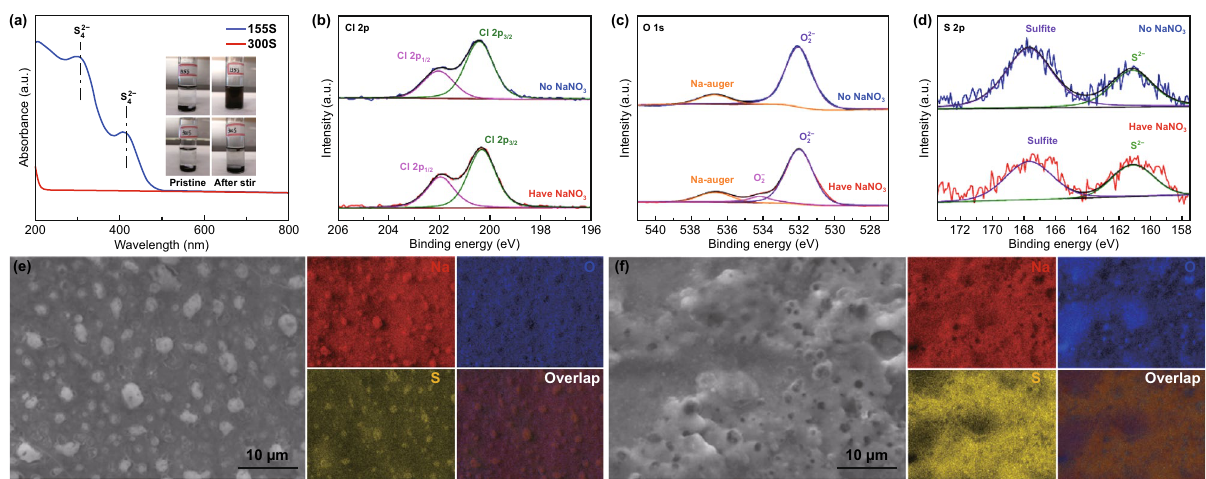
Fig. 5 a Photographs (inset) and UV–Vis spectra of 155S and 300S dispersed in ether electrolyte and stirred with Na metal for 5 min. b XPS spectra of the Na metal after cycling with the 155S electrode in ether electrolyte for 200 cycles for the Cl 2 p . c XPS spectra of the Na metal after cycling with the 155S electrode in ether electrolyte for 200 cycles for the O 1 s. d XPS spectra of the Na metal after cycling with the 155S electrode in ether electrolyte for 200 cycles for the S 2 s regions. e SEM image and EDS mappings of the Na metal after 200 cycles with the 155S in ether electrolyte with NaNO 3 additive. f SEM image and EDS mappings of the Na metal after 200 cycles with the 155S in ether electrolyte without